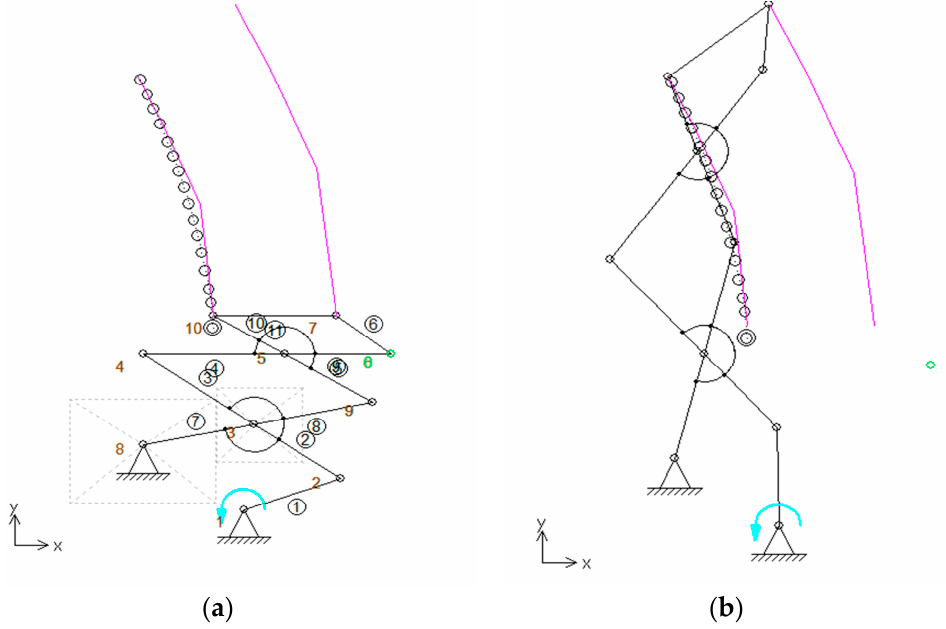
Figure 8. Optimized path (black circle) obtained by the Synthesis and Analysis of Mechanisms (SAM) software in the ( a ) initial position and ( b ) final position for the desired trajectory represented.